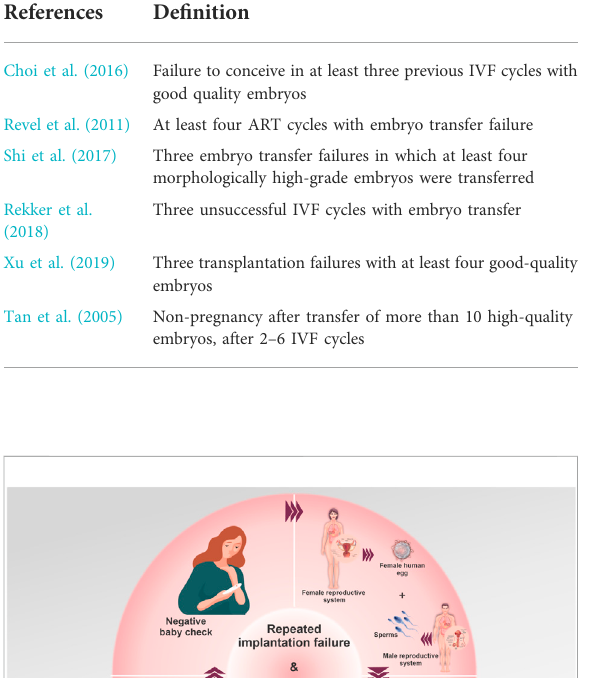
TABLE 1 De fi nition of RIF.